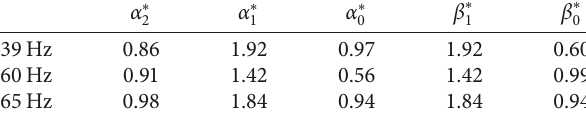
Table 1: The parameters of adaptive notch filter.